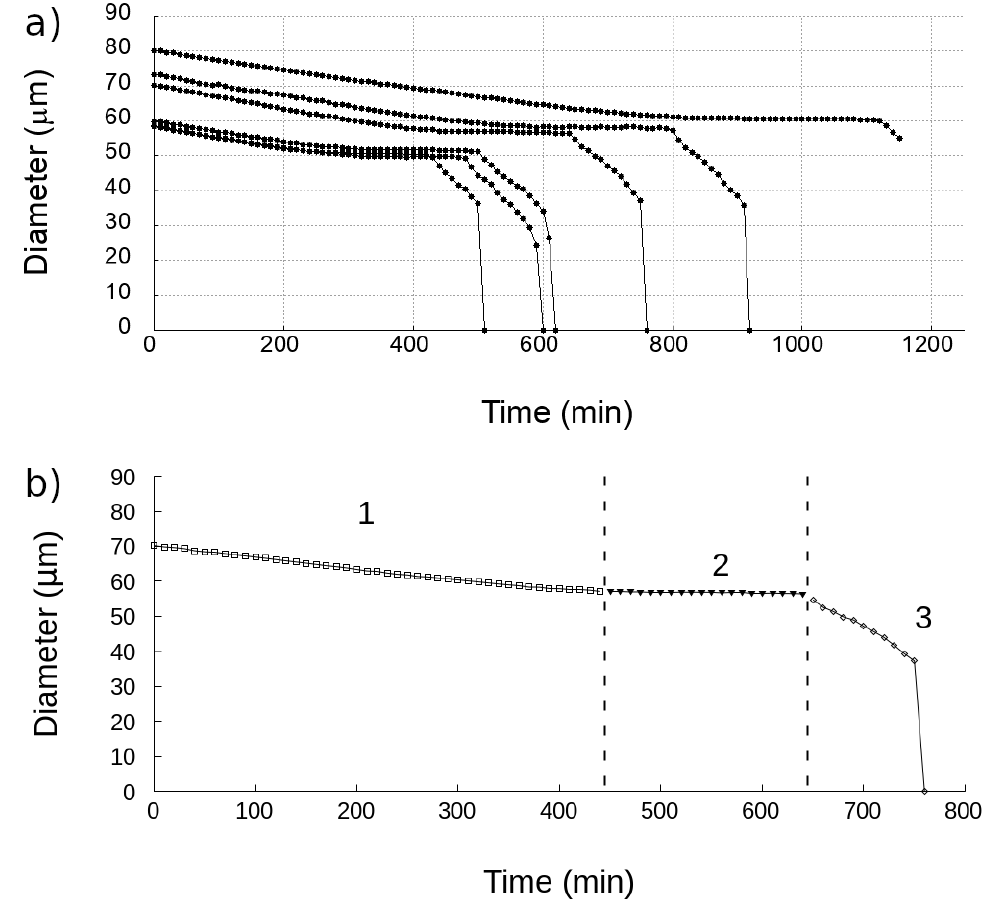
Figure 3. ( a ) Data showing the change of the diameter of water droplets under mineral oil from a bottom view as observed by the objective lens of an inverted microscope. Different curves correspond to different droplets. ( b ) The three distinctive phases of a representative d ( t )